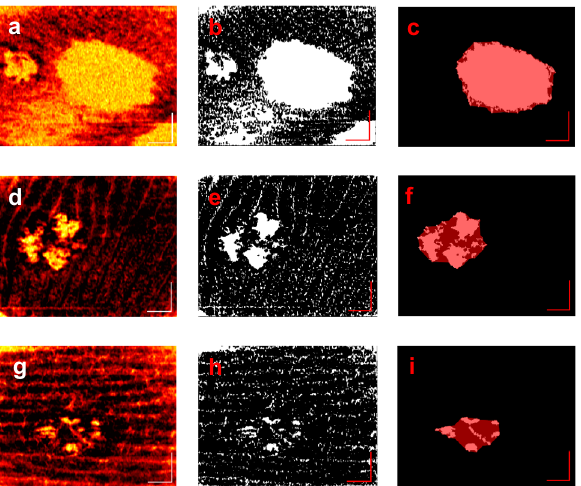
Figure 3. Three lesions from different patients demonstrating very different morphologies classifiable by VALVe. ( a - c ) is a deep slice example of a dense lesion, P2L2, with a VALVe = 0.903, ( d - f ) is a superficial slice example of an intermediate lesion, P1L1, with VALVe = 0.512, and ( g - i ) is a superficial slice example of a diffuse lesion, P3L1, with a VALVe = 0.290. The axis in each image represents a 1 mm × 1 mm bar.